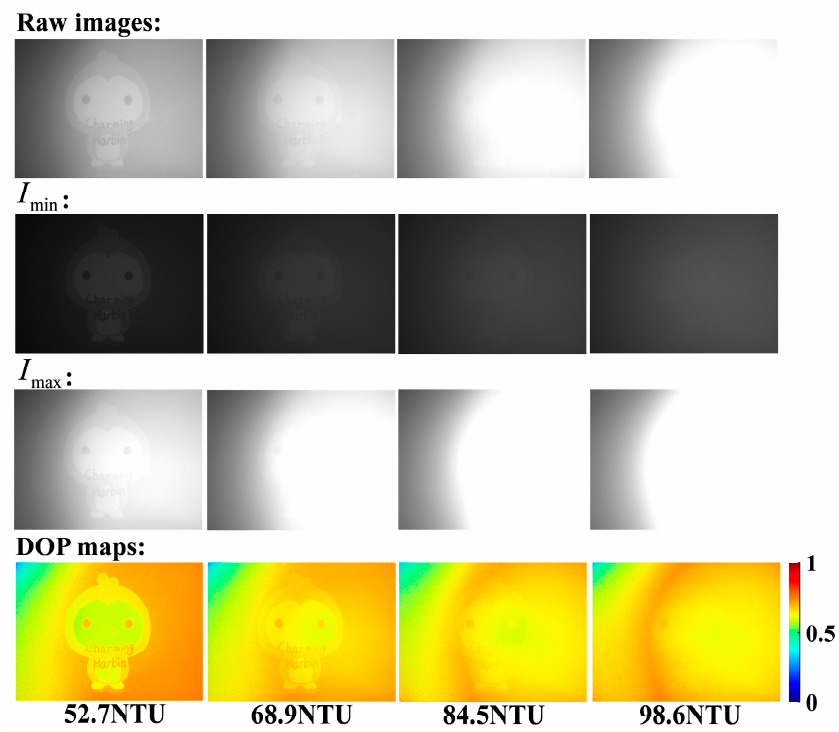
Figure 2. Raw images (first row), I min (second row) and I max (third row), and the calculated DOP distribution maps (last row) acquired in four high-turbidity environments.